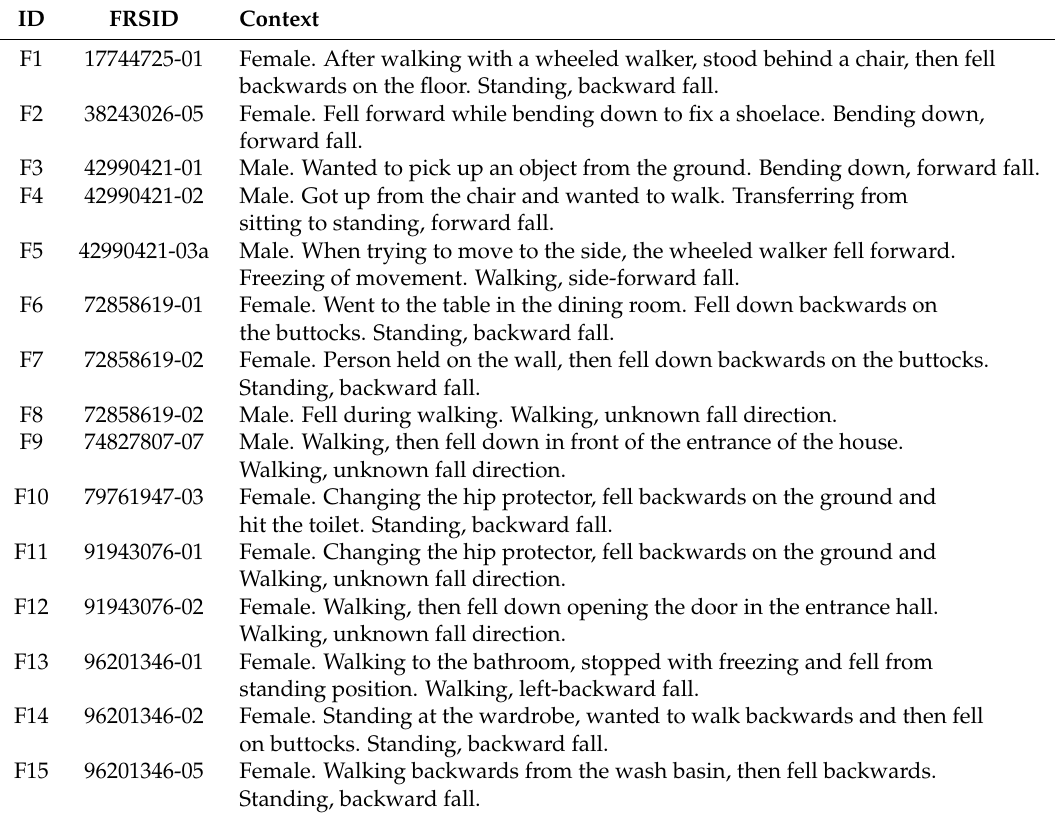
Table 2. FARSEEING dataset: Context information of each fall event for subjects wearing a 3DACC placed on the lower back. ID and FRSIDare the Identification within this study and that given in the dataset, respectively. The context is extracted from the FARSEEING documentation